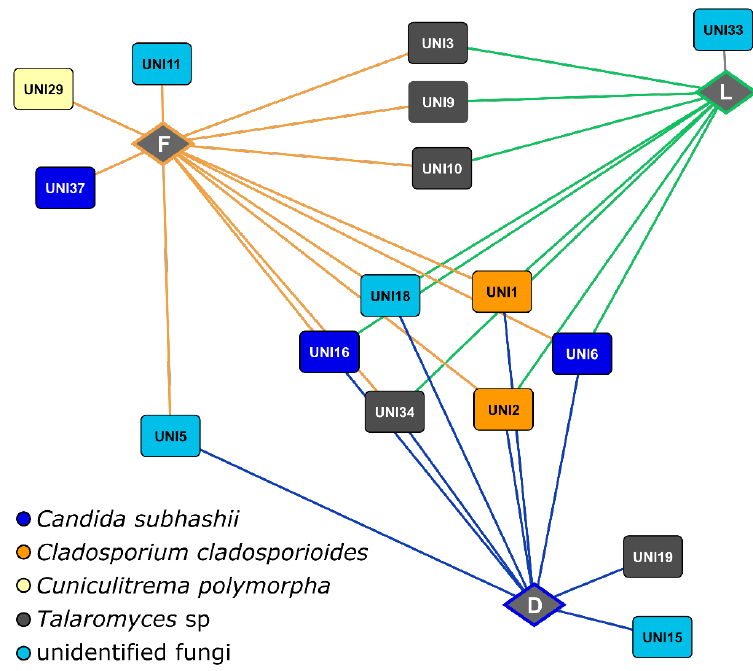
Figure 2. The core community of each grass species as well as fungal zOTUS identified in two or three grass species in both 2010 and 2011. Abbreviations: D, D. glomerata ; L, L. perenne ; F, F. rubra .